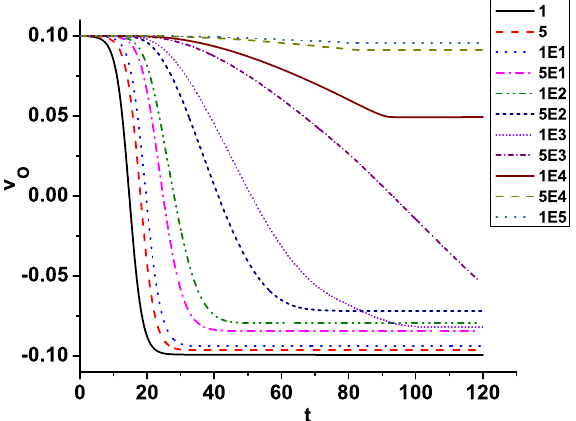
Figure 3 . The path of the object during its interaction with the wall. On the y-axis we have z O , which represents the location of the center of the object at some moment in time. The parameters are chosen to be A = 0 . 5 , initial v O = 0 . 1 , R = 1 . 5 , while the values for the object’s mass m are marked in the plot. If the object is light, its momentum and energy are low, so it bounces back from the wall. As it becomes more massive, the wall bends more and more, up until the point where energy and momentum are high enough so that the wall cannot stop it any more, and the object passes through the wall.